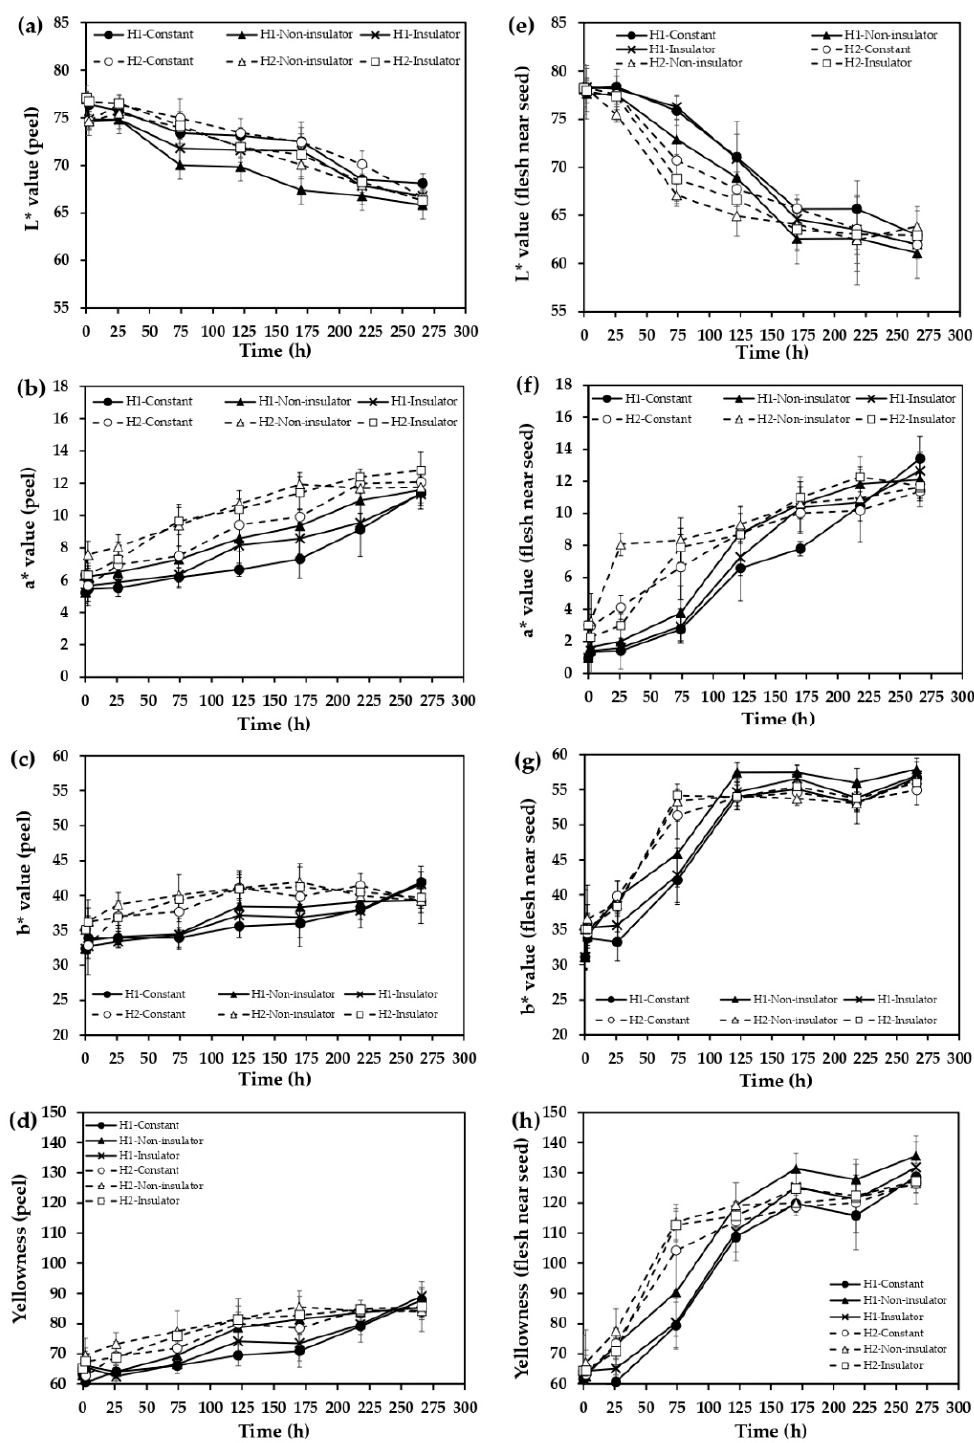
Figure 6. ( a ) L* , ( b ) a* , ( c ) b* value, and ( d ) yellowness of the peel of mango fruits; ( e ) L* , ( f ) a* , ( g ) b* value, and ( h ) yellowness of the flesh near the seed of mango fruits (‘Nam Dok Mai Si thong’) under constant, non-insulated, and insulated conditions during simulated handling at the tarmac. After simulated handling at the tarmac, mango fruits from the first and second harvest were transferred to 20 °C for 266 h. H1, first harvest; H2, second harvest. Vertical bars on the graph indicate S.D. ( n = 3).